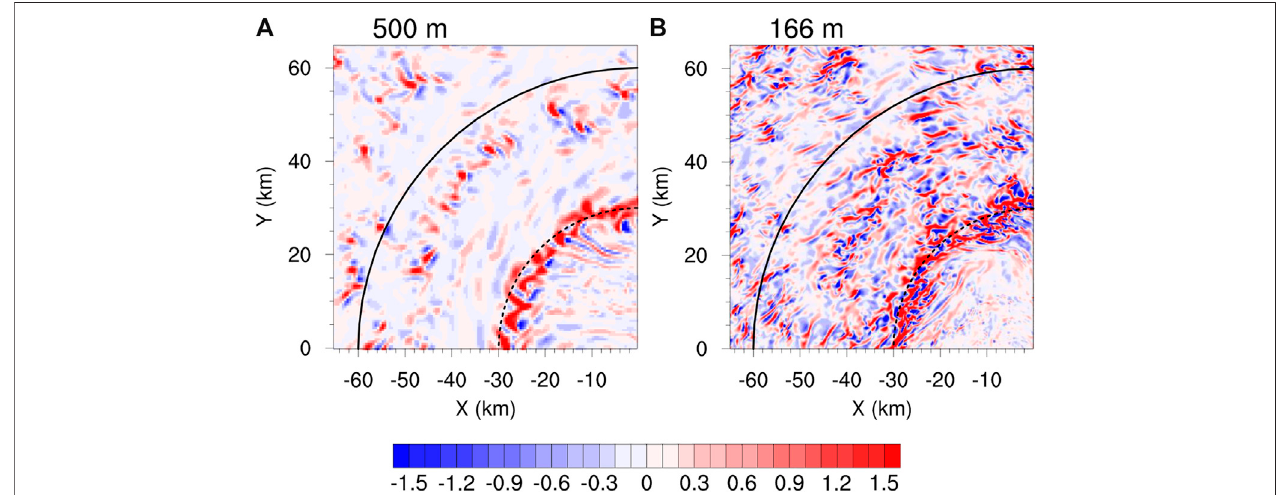
FIGURE 8 | Horizonal distribution of vertical velocity (m s − 1 ) at the 183-m height in the northwest quadrant at t (cid:2) 8.75 h of the simulation from the grid spacings of (A) 500 m and (B) 166 m, respectively.